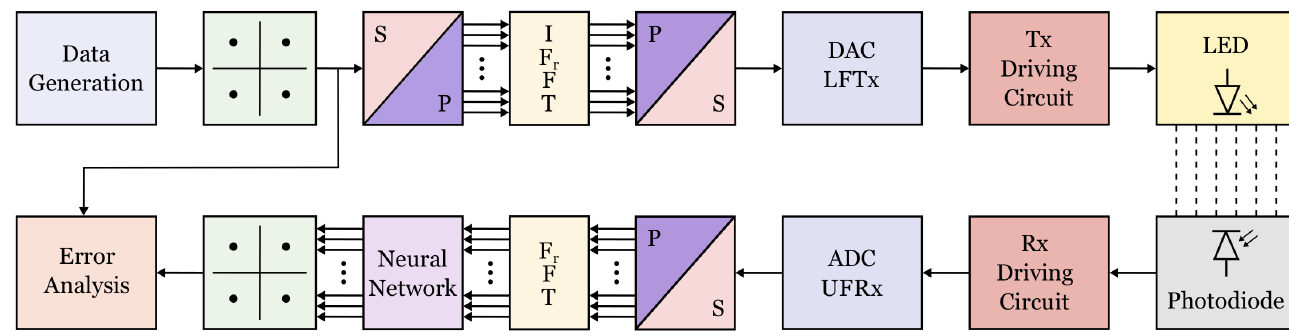
Figure 1. The block diagram of the system used in the